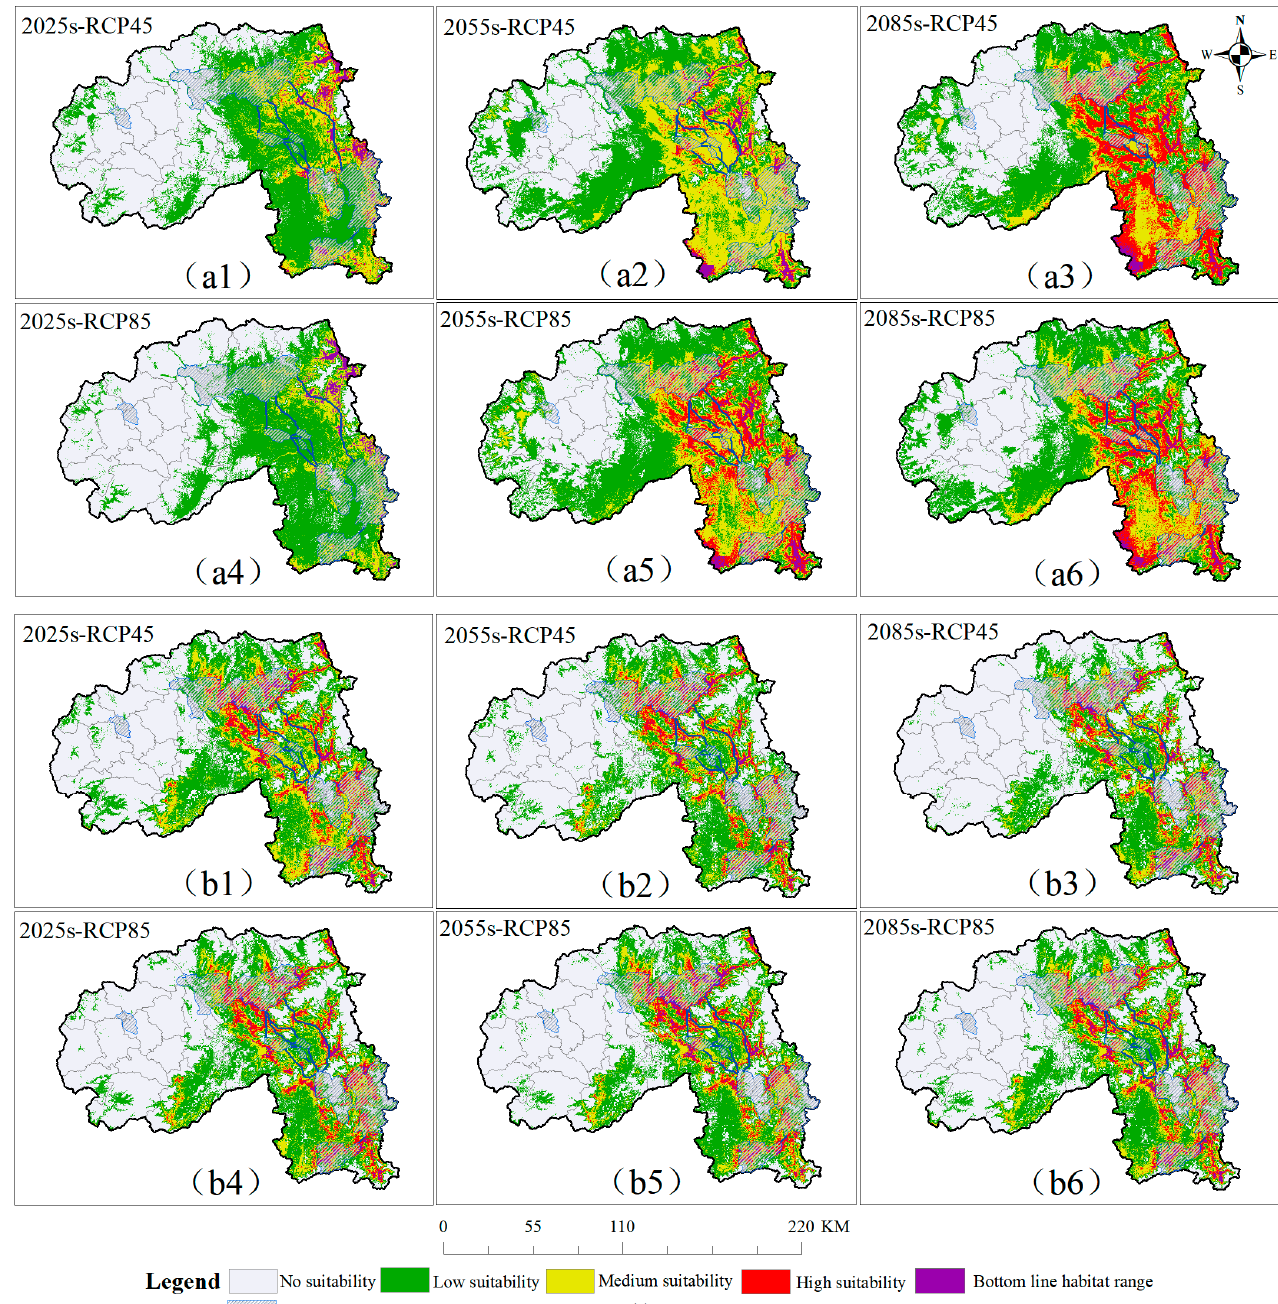
Figure 7. Predicted future suitable areas for Asian elephants in Sipsongpanna. ( a1 – a6 ) Future suitable areas for 2025-RCP45, 2055-RCP45, 2085-RCP45, 2025-RCP85, 2055-RCP85, and 2085-RCP85 under NAI (Non-anthropogenic Interference). ( b1 – b6 ) Future suitable areas for 2025-RCP45, 2055-RCP45, 2085-RCP45, 2025-RCP85, 2055-RCP85, and 2085-RCP85 under AI (Anthropogenic Influence).